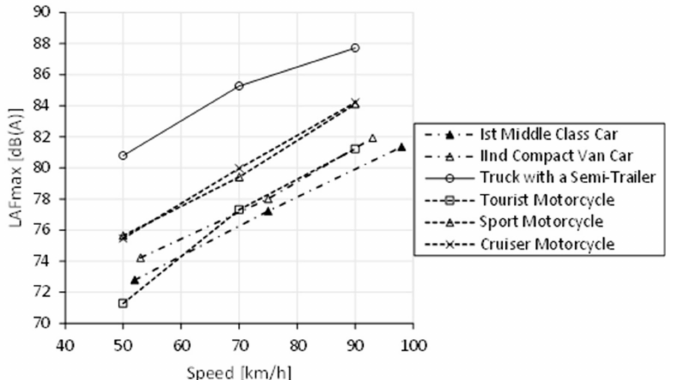
Figure 1. Influence of di ff erent means of transport and their travelling speed on the maximum sound level near the roadway (measured at a distance of 7.5 m from the vehicle movement axis)